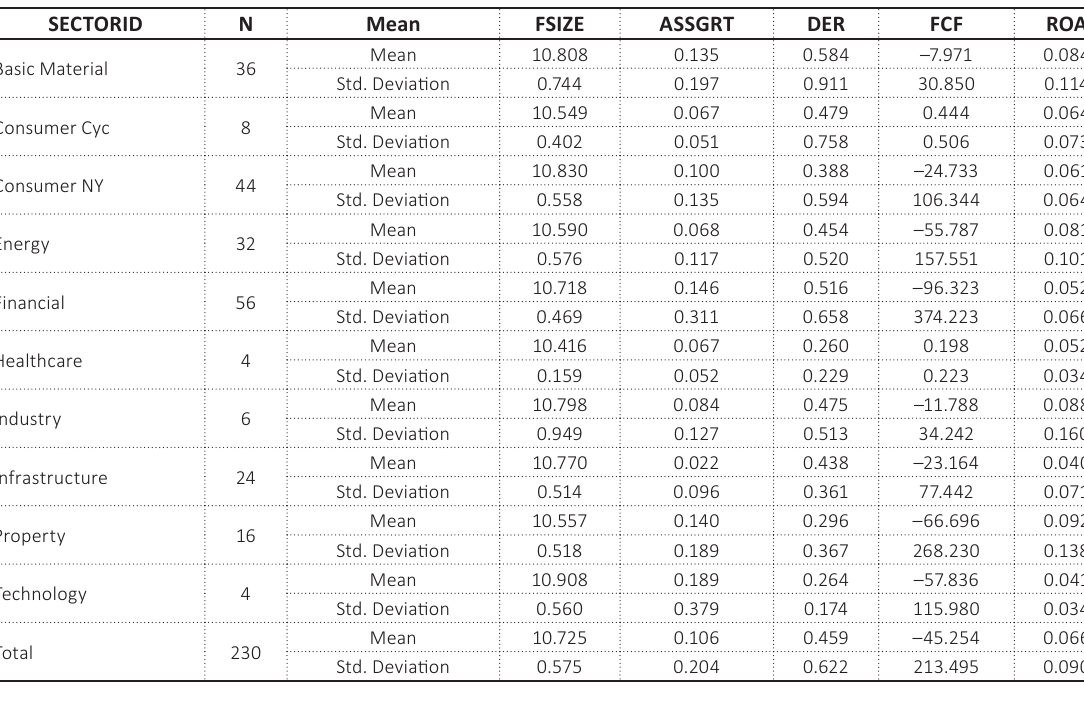
Table 4. Descriptive statistics (FSIZE, ASSGRT, DER, FCF, ROA) by sector